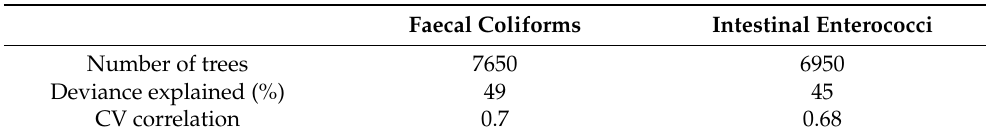
Table 2. Predictive performance of the final models developed for the microbiological indicators quantified in wells in Guinea-Bissau. Final settings: bag fraction—0.5; tree complexity—1; no. folds—10; learning rate—0.001.